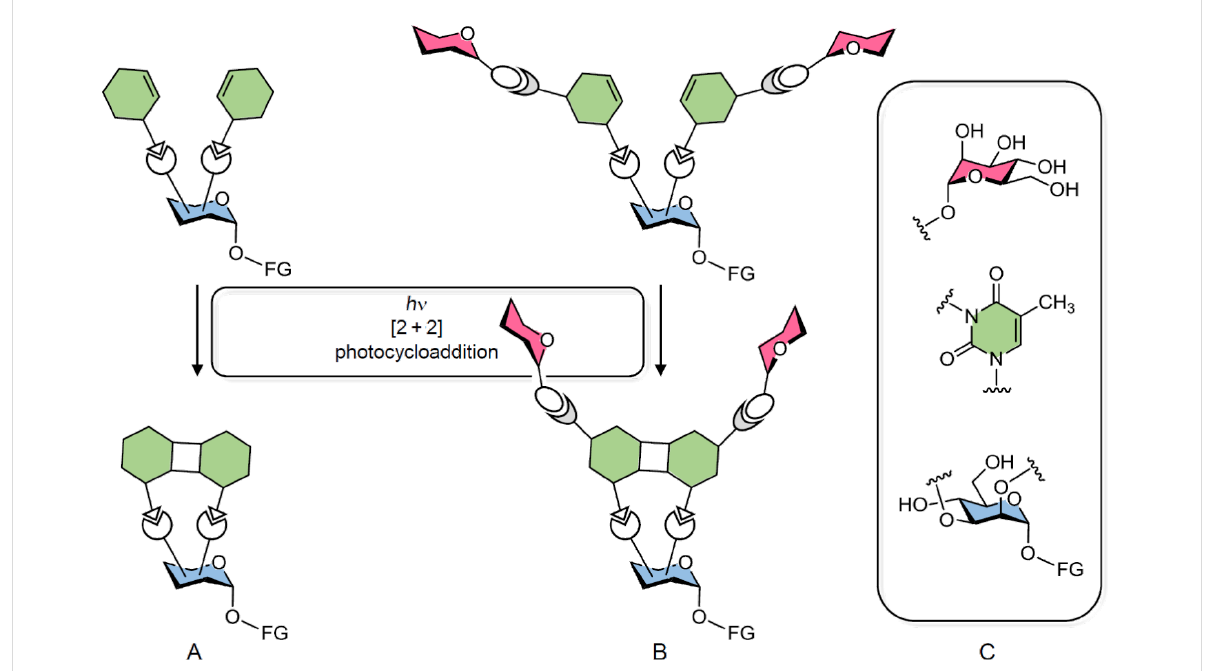
Figure 1: Cartoon of a divalent carbohydrate-scaffolded molecular architecture that allows control of the flexibility of both branches by intramolecular [2 + 2] photocycloaddition (A). To attach the photocontrollable moieties (green) to the carbohydrate scaffold (blue), an appropriate ligation chemistry is required. Additional ligation of sugar ligands (pink) leads to the analogous divalent glycothymine glycoconjugate (B). As building blocks for this mo- lecular architecture a mannoside scaffold (blue), thymine (green), and α -D-mannosyl ligands (pink) were used (C). FG = functional